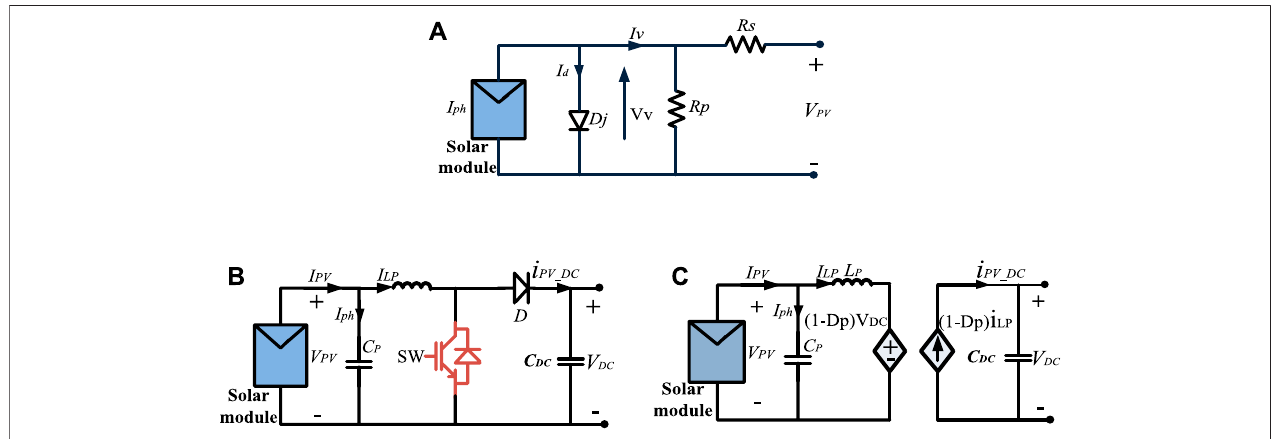
FIGURE 2 | (A) Circuit of stand-alone single photovoltaic cell, (B) dynamic PV, converter circuit diagram, and (C) equivalent diagram.